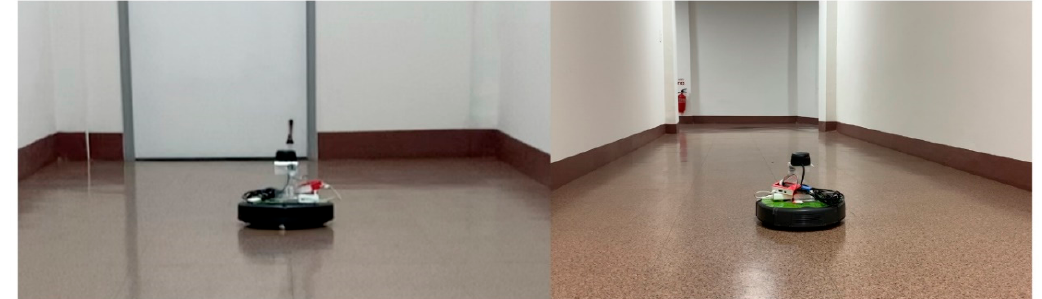
Figure 23. Integrated image of scanned result in second autonomous scanning experiment. The numbers indicate the positions after movement form the starting position of the autonomous scanner ( left ); also, the trajectory of the autonomous scanner is indicated ( right ).